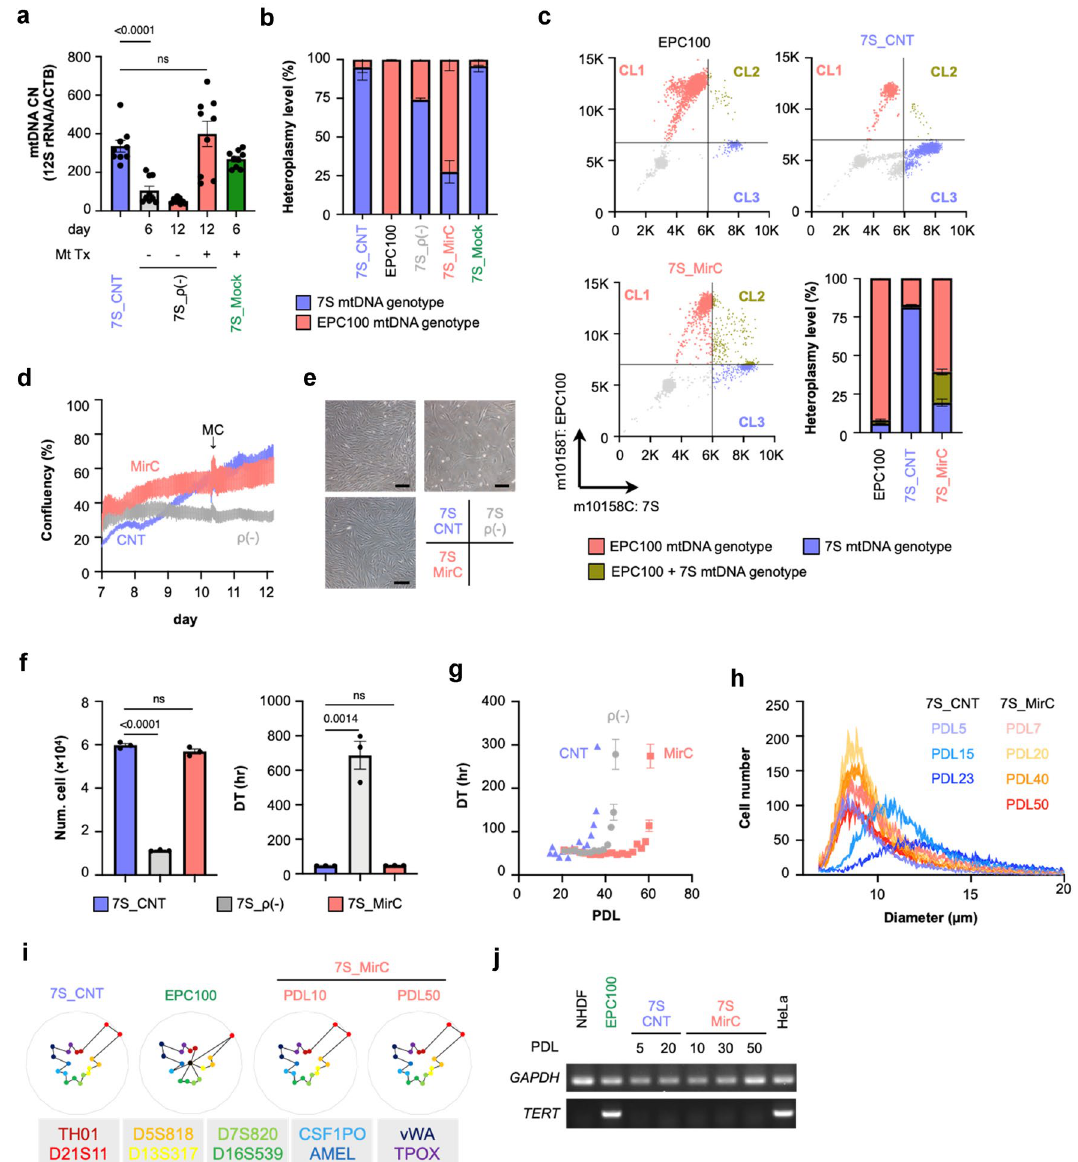
Figure 2. MirCs were generated from mitochondrial disease patient-derived (7S) fibroblasts. ( a ) mtDNA CN during the procedure of MirC generation. Fibroblasts that received gene transfer, designated as 7S_ρ(-) were cultivated with or without isolated mitochondria. Mock transfectants that received a plasmid without the endonuclease, designated as 7S_Mock, were subjected to the same protocol. (n = 9, respectively). ( b ) TaqMan qPCR SNP genotyping assay demonstrated the dominance of exogenous mtDNA. MirCs derived from 7S fibroblasts were designated as 7S_MirC. (n = 3, respectively). ( c ) Heteroplasmic sc-ddPCR discriminated three different populations: healthy homoplasmic cells (Cluster 1: CL1, red), heteroplasmic cells (CL2, brown), and mutated homoplasmic cells (CL3, blue) for mtDNA. Representative analyses are shown in the quadrant plotting, and the averages are depicted as a bar graph. Donor mitochondria for MirCs were isolated from EPC100 cells. (n = 3, respectively). ( d ) Cell growth of MirCs compared with the original cells and ρ(-) cells by using time- lapse imaging recorder from day 7 to day 12 in the protocol. The confluency was automatically calculated by JuLI STAT software. ( e ) Microscopic photographs of cell cultures following mitochondrial replacement 5 days after replating at a concentration of 1 × 10 5 cells on day 12 in the protocol. ( f ) The yield of cells and the doubling time of MirCs were similar to those of 7S fibroblasts. The black bar indicates 200 µm. (n = 3, respectively). ( g ) Long-term culture showed the lifespan extension of MirCs. (n = 3, respectively). ( h ) The cell size of MirCs was maintained during culture, whereas that of the original cells was significantly enlarged from early PDL with time. (n = 3, respectively). ( i ) Short tandem repeats (STRs) demonstrated no contamination of the original MirCs by EPC100 cells that provided the donor mitochondria for MirCs. ( j ) TERT expression in MirCs to deny carcinogenic transformations. The full-length gel of cropped gels is shown in Supplementary Fig. S4. mtDNA, mitochondrial DNA. CNT, no treatment control cell. ρ(-), rho minus, indicates cells with a low mtDNA number. CN, copy number. MC, medium change. DT, doubling time. PDL, population doubling